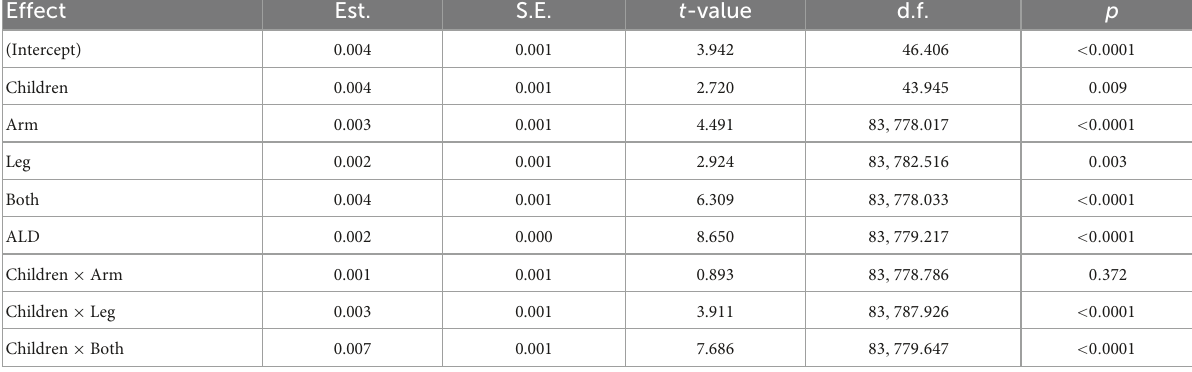
TABLE 1 Linear mixed effects model for predicting the intersubject correlation (ISC) with subject-level random